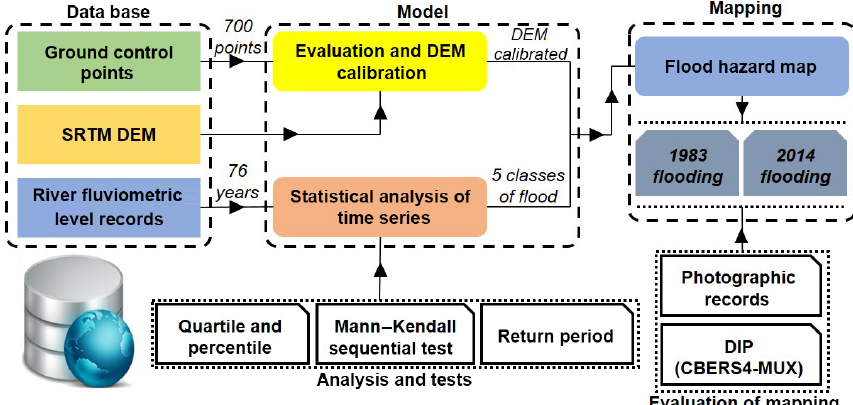
Figure 4. Flowchart of the proposed approach for the delimitation of flood hazard